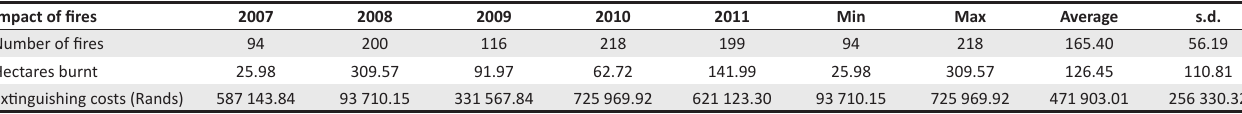
FIGURE 2: Extent of risk at Roburnia Plantation using the United Nations International Strategy for Disaster Reduction equation. TABLE 2: Impact of fires at Roburnia Plantation between 2007 and 2011. Impact of fires